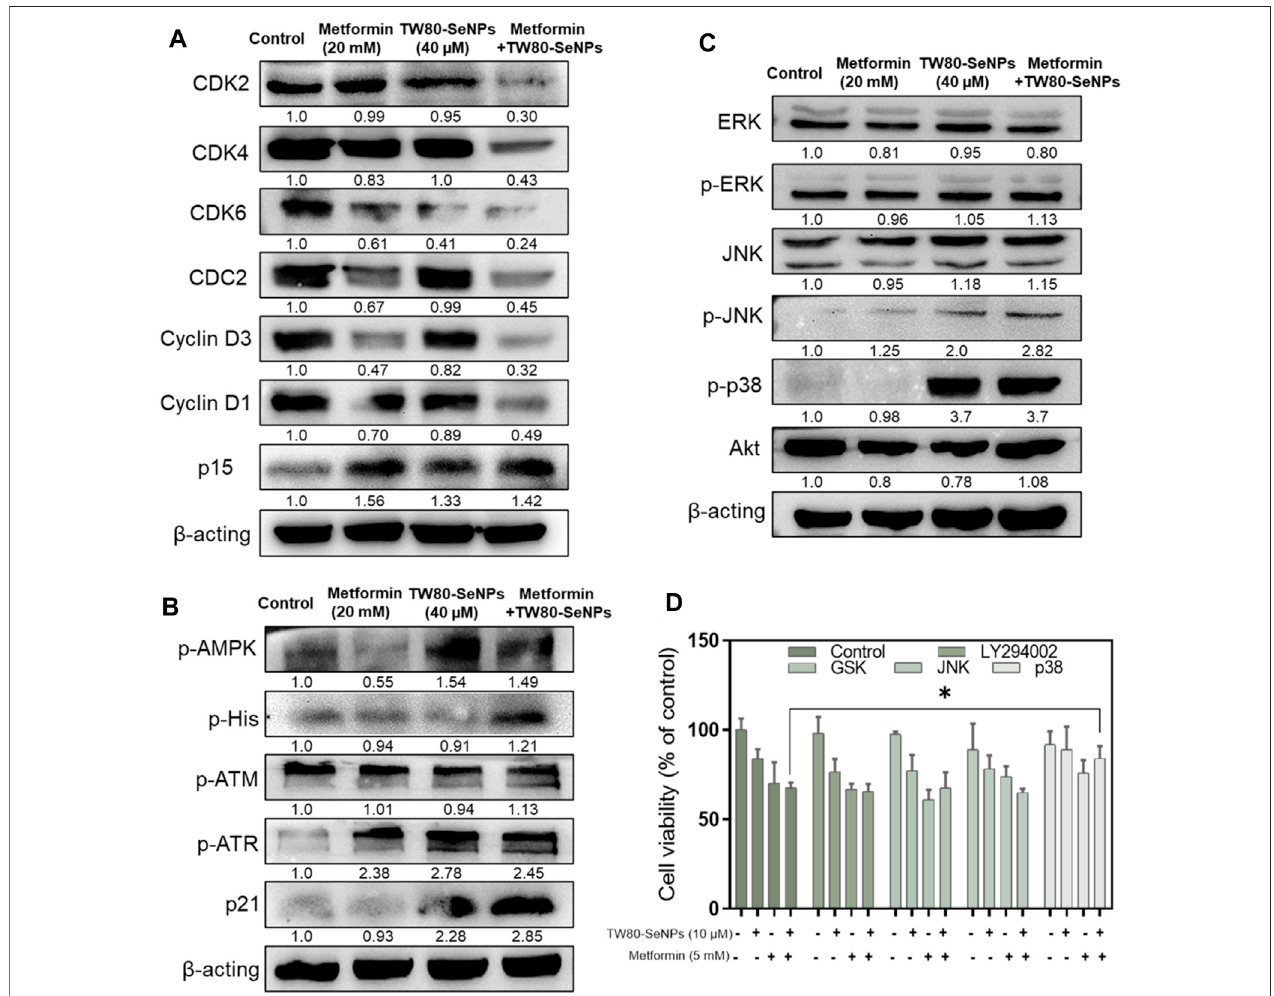
FIGURE6| EffectsofTW80-SeNPscombinedwithmetforminonexpressionofsignalingproteinsincells. (A) Proteinsassociatedwithcellcyclearrest. (B) Proteins related to DNA damage. (C) MAPK-related proteins. (D) Cell survival rates after addition of signaling protein inhibitors.